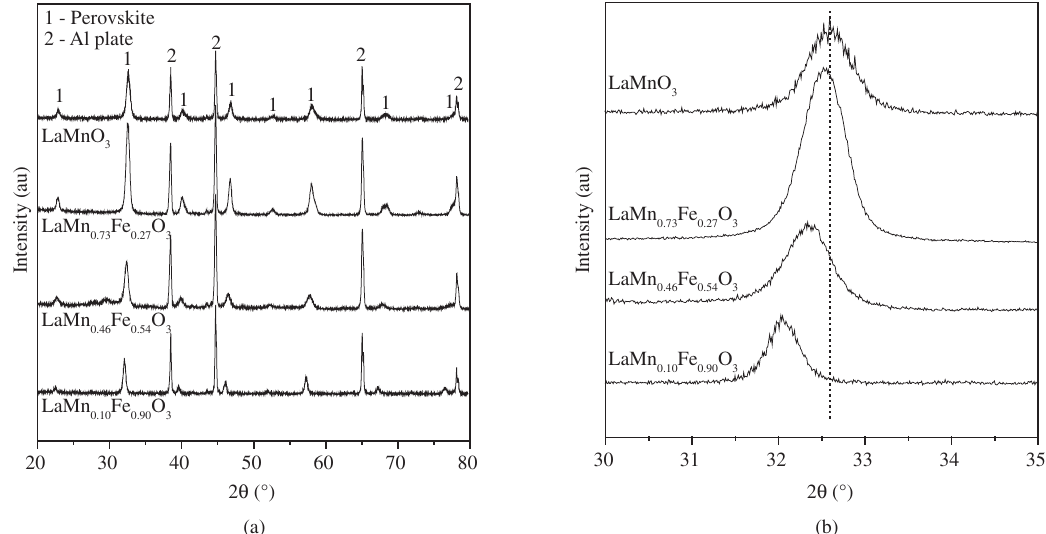
Figure 1. a) XRD of the perovskites LaMn